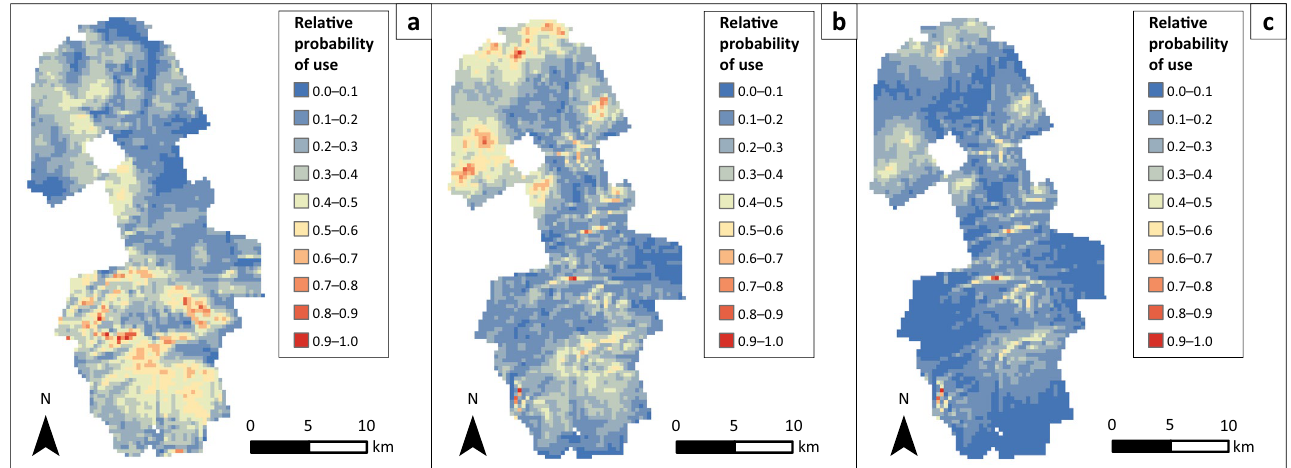
FIGURE 4: Average relative probability of use by elephants in Addo Elephant National Park. Maps reflect the predicted relative probability of use in (a) the morning (06:00), (b) midday (12:00) and (c) afternoon (16:00), averaged across the 70 sixteen-day periods corresponding to the Moderate Resolution Imaging Spectroradiometer composites.